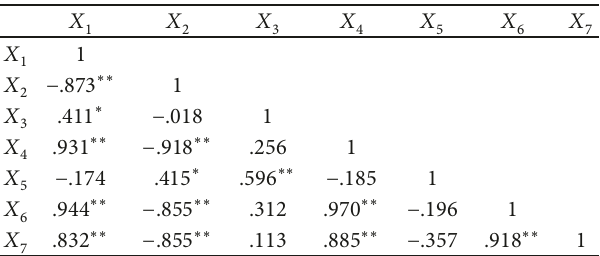
Table 1: Correlation